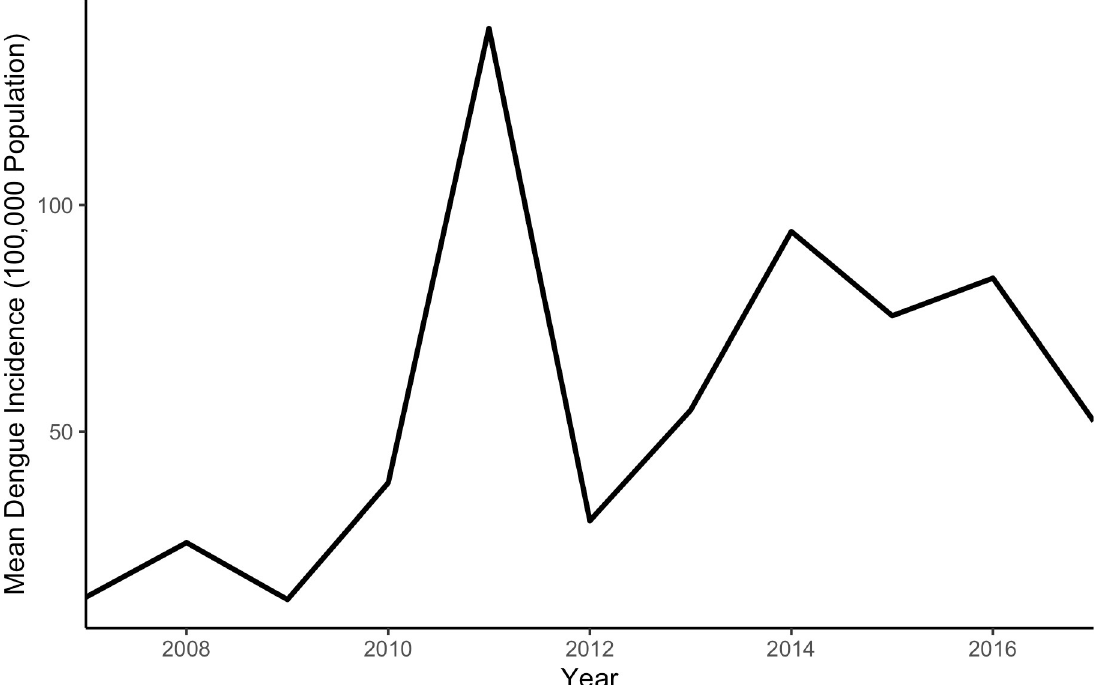
Fig 1. Dengue incidence per 100,000 in Amazonas